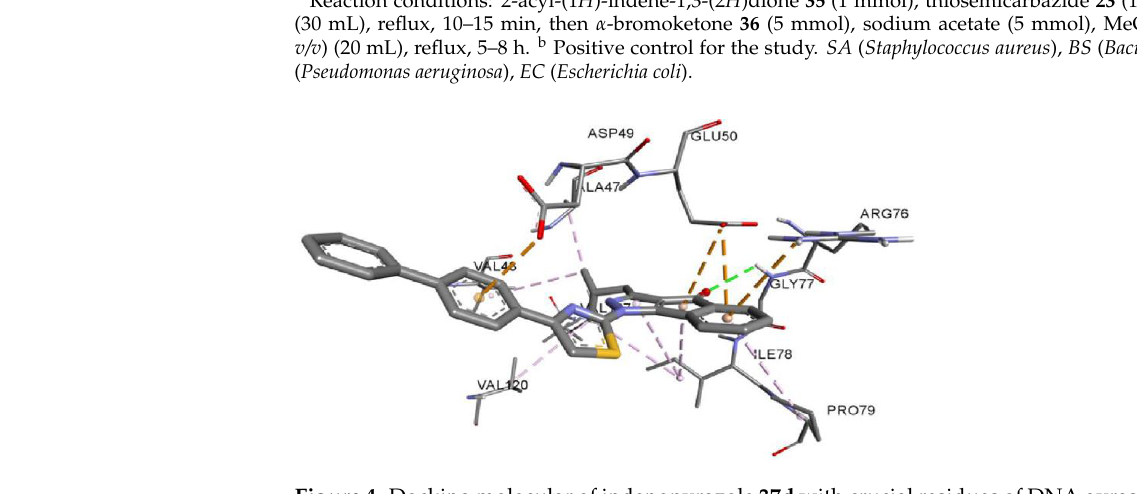
Figure 4. Docking molecular of indenopyrazole 37d with crucial residues of DNA gyrase of Escherichia coli (PDB ID: 1KZN). Image adapted from Mor et al. [36].